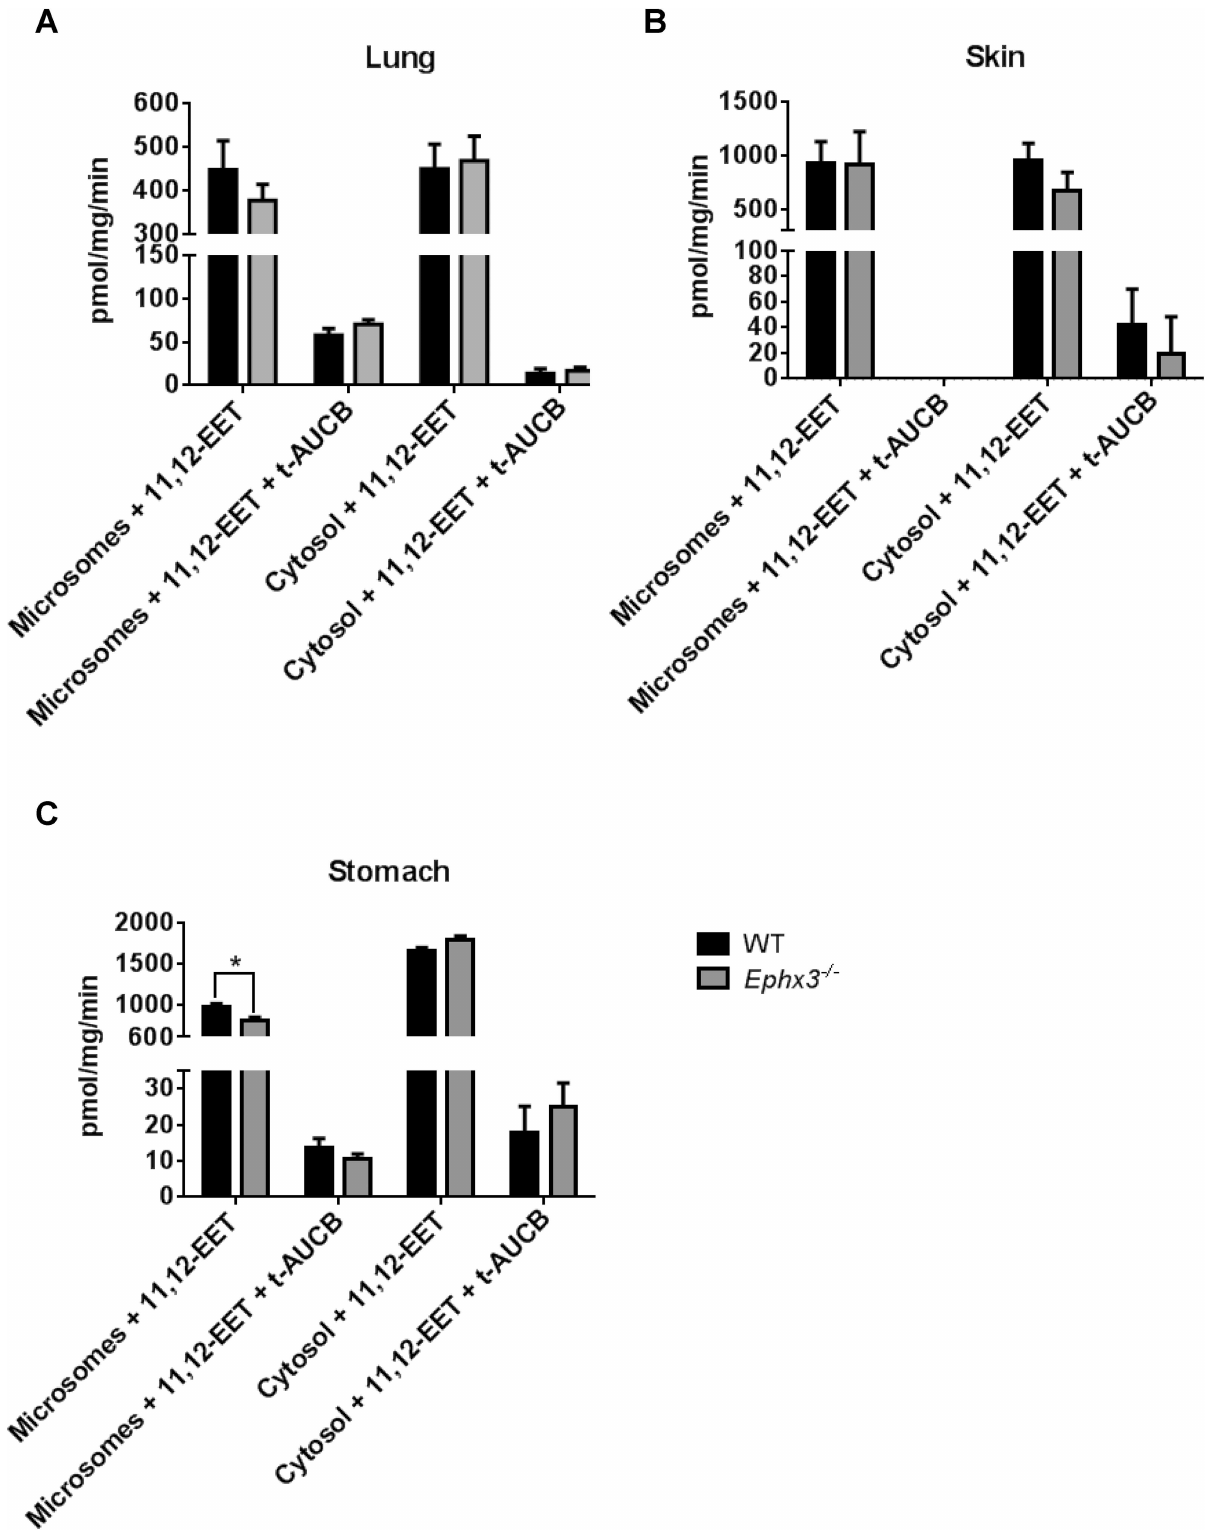
Fig 7. 11,12-DHETformation rates are largely unchanged in microsomal and cytosolic fractions from various tissues of Ephx3 -/- mice. LC-MS/MS analysisof 11,12-DHET formation in microsomal and cytosolic fractions after a 5 minute incubation with synthetic 11,12-EET with/without the EPHX2 inhibitort-AUCB in (A) lung, (B) skin, and (C) stomach samples(n = 3–6, * p < 0.05).